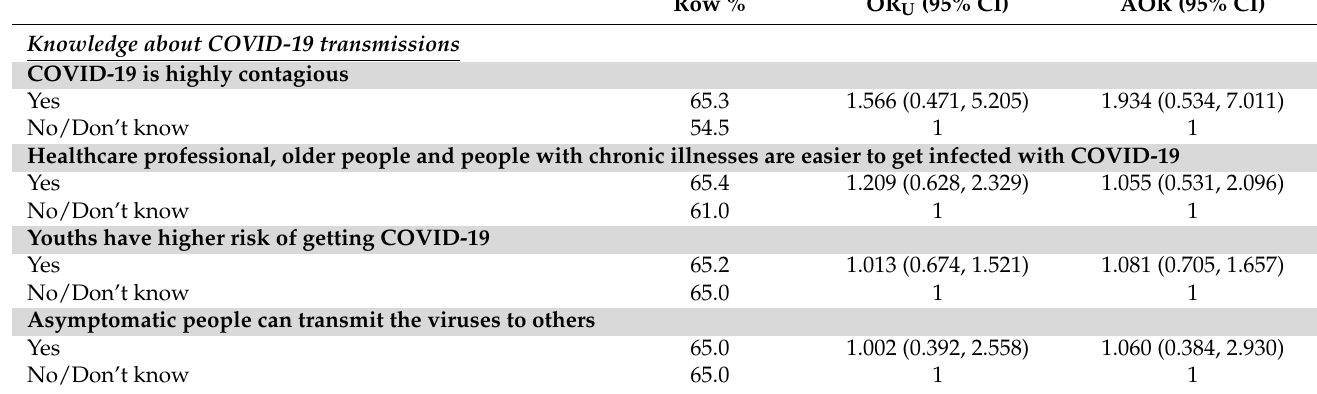
Table 4. Associations between factors related to COVID-19 vaccine and the intention to get vaccinated (N =